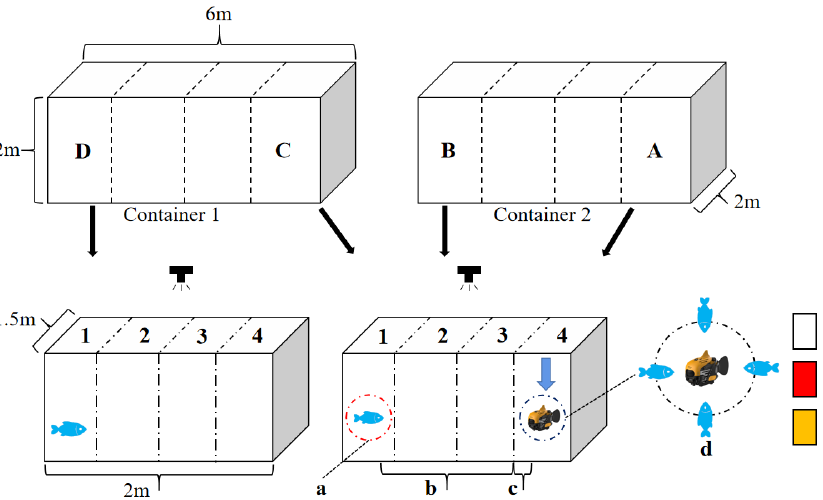
Figure 1. Schematic diagram of the setup for experiment one. a represents the freezing time; b represents the exploration of new object; c represents the close to new object; d represents the observation of new object.